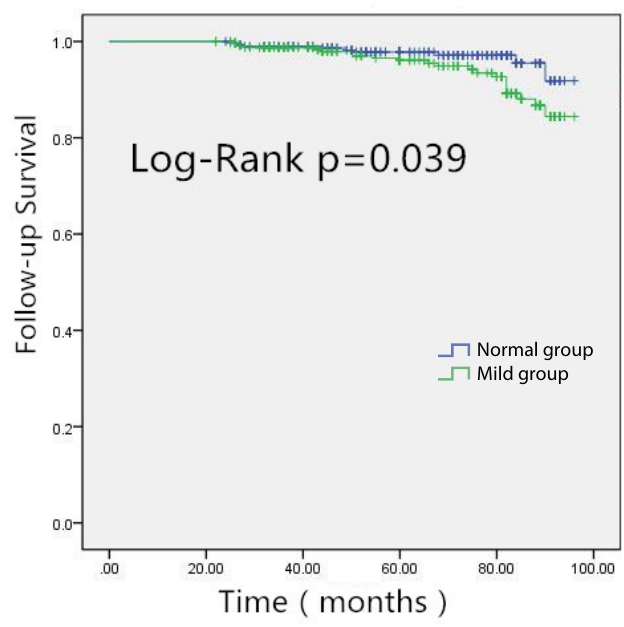
Normal group Mild